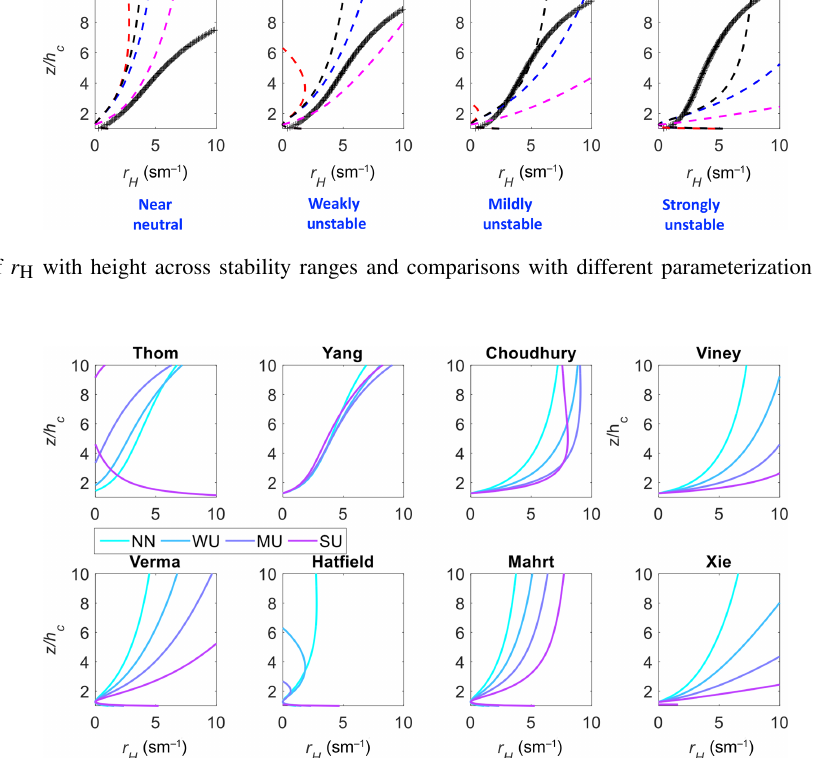
et al. (1976) (blue dashed line), Hatfield et al. (1983) (red dashed line), Mahrt and Ek (1984) (black dashed line), and Xie (1988) (pink dashed line). It should be noted that a